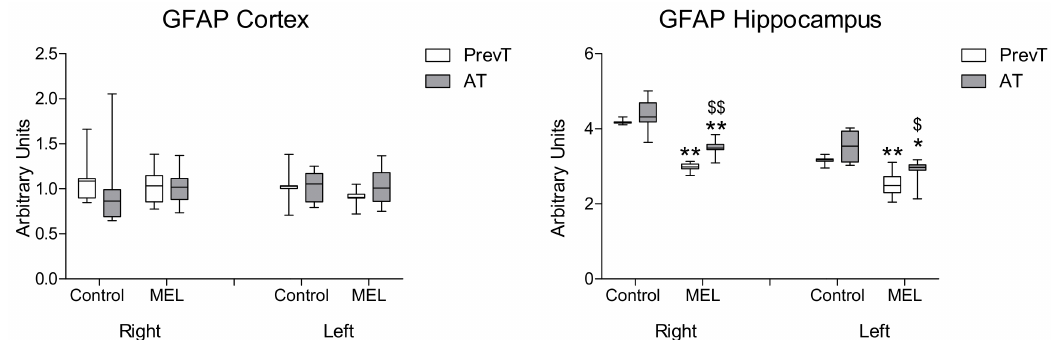
Figure 3. Right and left cortical and hippocampal mRNA expression of GFAP in 18-month-old rats in control (non-treated) conditions, after treatment with a daily dose of melatonin (10 mg/kg b.w.) from 24 h before until 7 days after surgery (PrevT), and treated only after surgery during 7 days (AT). Each value represents the median, interquartile and full range of five determinations performed in duplicate. * p < 0.05 with respect to the values obtained in the control group; ** p < 0.01 with respect to the values obtained in the control group; $ p < 0.05 with respect to the values obtained in the PrevT group; $$ p < 0.01 with respect to the values obtained in the PrevT group.